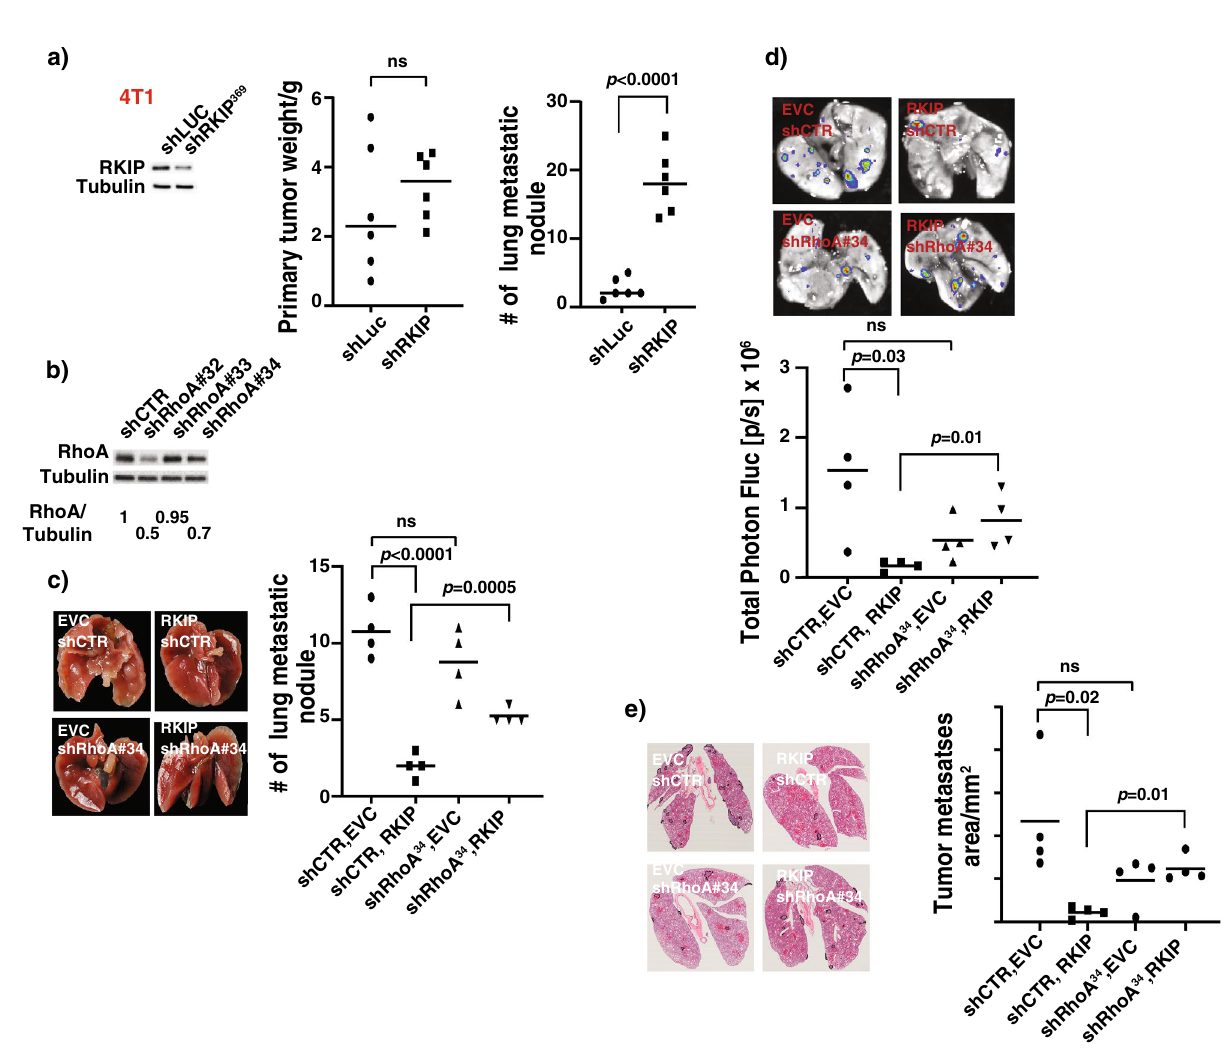
Figure 6. Increased RhoA expression is required for RKIP-mediated suppression of breast cancer metastasis in a murine allograft model. ( a ) (Left panel) Representative western blots of lysates prepared from control knockdown (shLUC), or RKIP knockdown (shRKIP 369 ) 4T1 cells. (Middle panel) Weight of primary tumors harvested from Balb/c mice 30 days after orthotopical implantation with the indicated 4T1 cells shown in the left panel. (Right panel) Number of lung metastatic nodules recorded in Balb/c mice 30 days after orthotopical implantation with the indicated 4T1 cells shown in the left panel. n = 6. ( b ) Representative western blots of lysates prepared from control knockdown (shCTR), or three different RhoA knockdowns (shrhoA#32-34) 4T1 gfp-luc cells. ( c ) (Left panel) Representative ex vivo color images of lungs harvested from mice orthotopically injected with the indicated 4T1 gfp-luc cells showed in ( b ), (Right panel) Quantification of lung metastatic nodules (mean ± SE) detected in lungs harvested from mice orthotopically injected with the indicated 4T1 gfp-luc cells shown in ( b ). n = 4. ( d ) (Top panel) Representative ex vivo BLI images of lungs harvested from mice orthotopically injected with the indicated 4T1 gfp-luc cells shown in ( b ), (Bottom panel) Photon flux quantification of (mean ± SE) BLI images shown in the top panel. n = 4. ( e ) (Left) Representative hematoxylin and eosin (H&E) stained cross-sections of lungs harvested from mice orthotopically injected with the indicated 4T1 gfp-luc cells showed in ( b ) showing metastases demarcated from normal tissues with black solid line. (Right panel) total tumor metastases area calculated from the H&E sections shown above. n = 4. Unpaired Student’s t-test (two-tailed) was used for all analyses with p < 0.05 considered significant. ns not inhibits F4/80 + macrophage infiltration by decreasing CCL5 expression in cancer cells 6 . Here we show that the RKIP-mediated inhibition of CCL5 expression and F4/80 + cells tumor infiltration can be reversed by silencing of of RhoA expression suggesting RKIP may regulate CCL5 expression through RhoA GTPases.